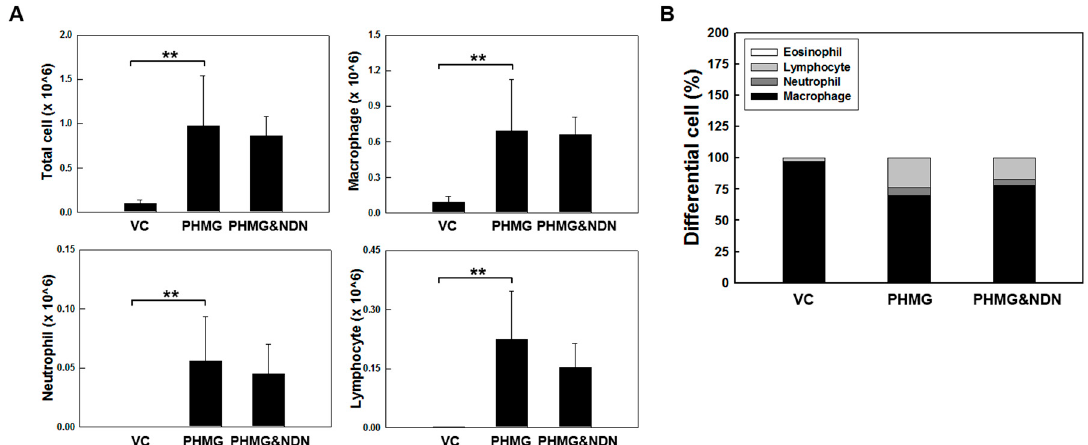
Figure 2. Effect of NDN on PHMG-induced changes in total and differential cell counts in the BALF of mice. The number of total cells, macrophages, neutrophils, and lymphocytes ( A ) in the BALF and composition of cell populations as a percentage of total cells ( B ) in VC, PHMG, and PHMG & NDN groups. Data are presented as the means ± SD ( n = 6/group). ** p < 0.01 vs. VC group.